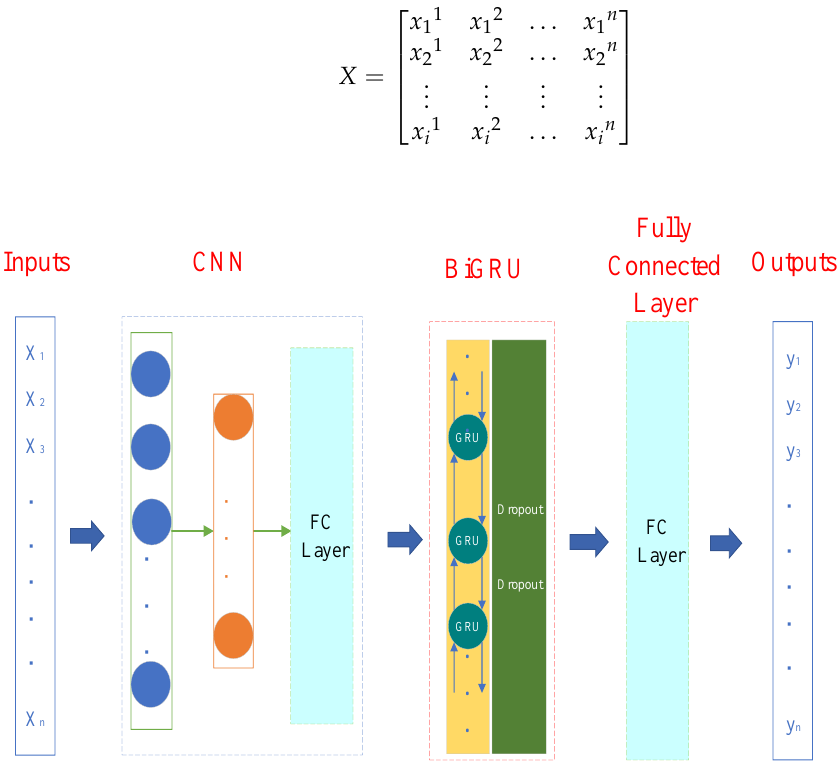
Figure 4. CNN-BiGRU prediction model structure diagram.